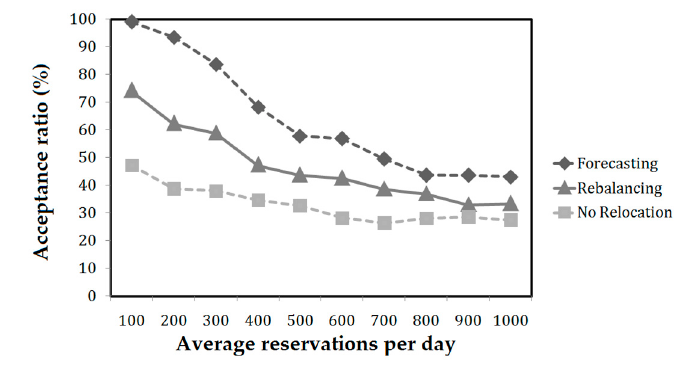
Figure 12. Impact of the number of reservations on the acceptance ratio.